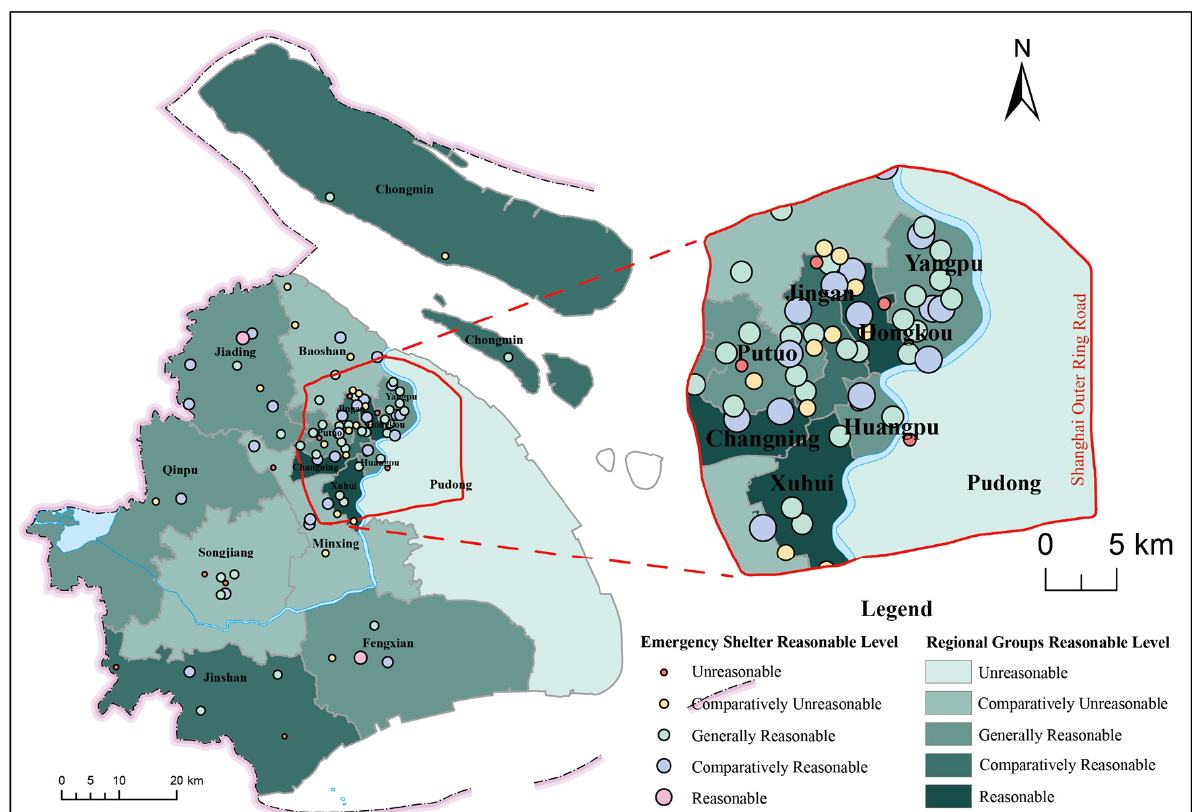
Figure 7. Spatial distribution of evaluation results of emergency shelters.